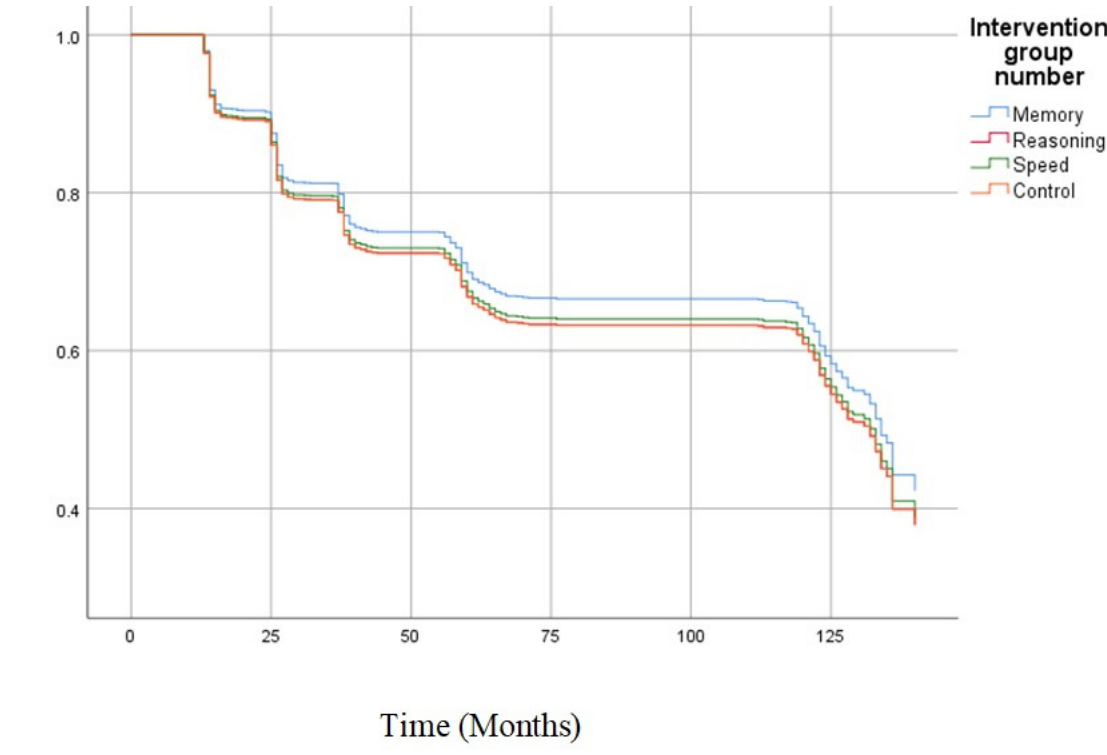
Figure 2. Survival curves of the low-risk sample. There were no significant differences between speed of processing, memory, or reasoning training with the control group and the low-risk sample ( p > 0.05).